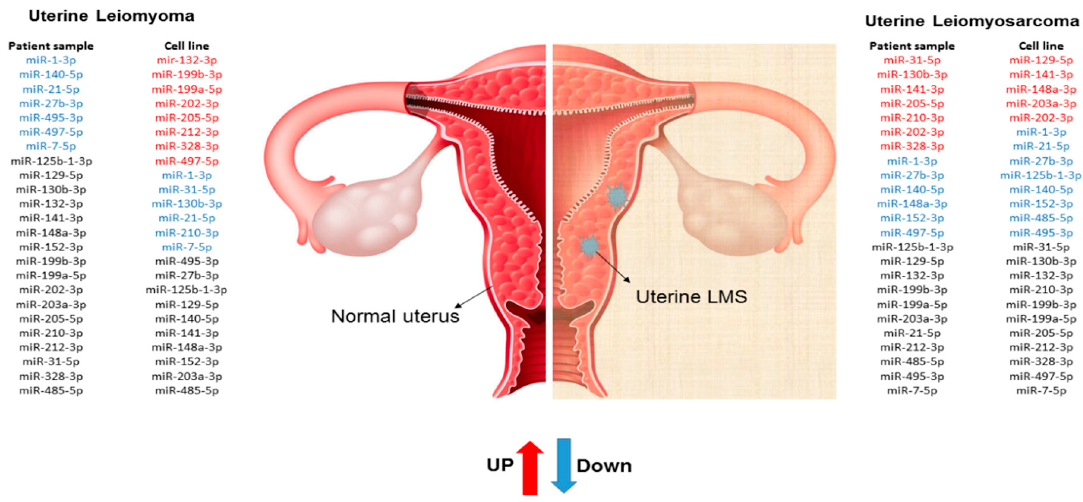
Figure 6. Schematic illustration of miRNAs expression profile in cell and patient samples. Network of genetic interactions of miR-7-5p, miR-1-3p, miR-140-5p, and miR-202-3p were described in Figures 7 and 8. miRNAs molecular structures and miRNA-target interactions regions in Figure 9.